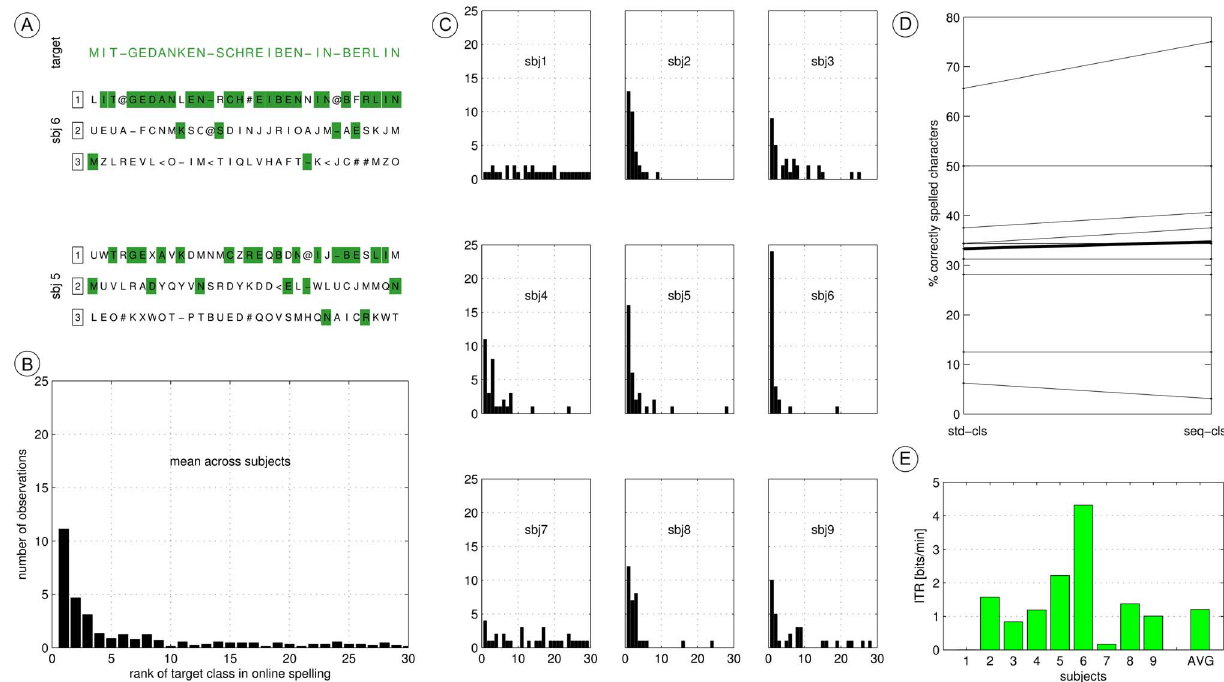
Figure 8. Online spelling accuracy. Plot A–C describe the spelling accuracy obtained by the sequential classifier. The target sentence and the top-3 ranked characters of two users are shown in A . Histogram B depicts the rank of the target letter averaged across subjects. The individual rank- histograms are shown in C. Plot D depicts the spelling accuracy (rank=1) of the standard classifier and the sequential classifier for each subject and the grand average (thick line). Plot E depicts the information transfer rate for each subject.